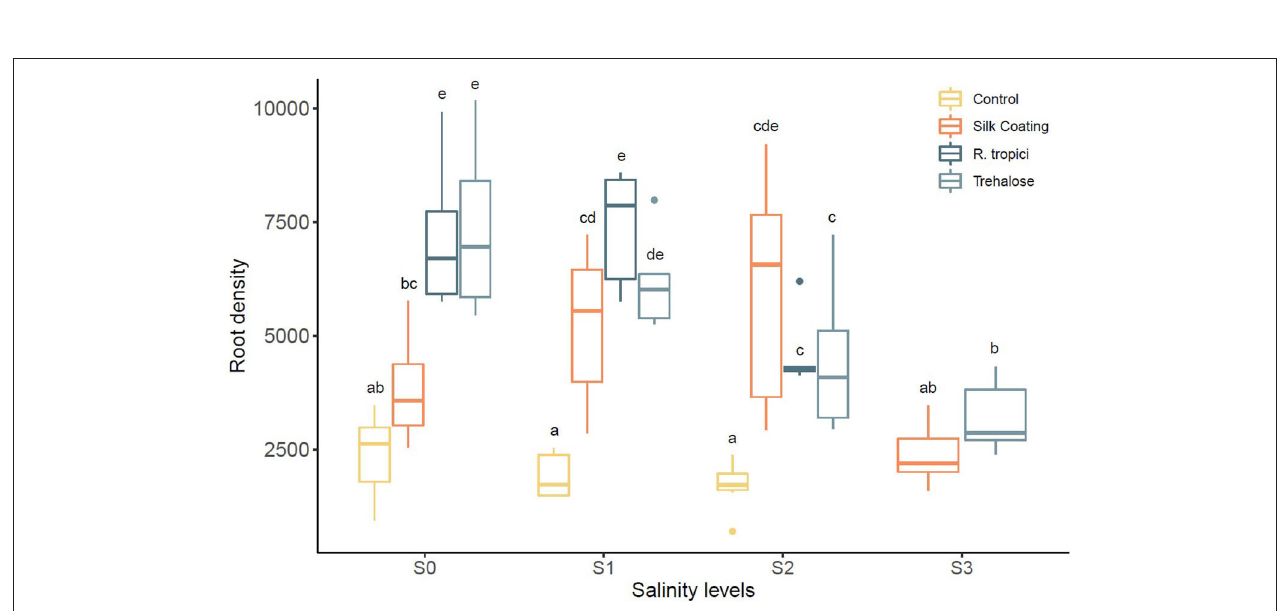
FIGURE 3 | Effect of different salinity levels ( S0 = 0mM, S1 = 25mM, S2 = 50mM, and S3 = 75mM) on Phaseolus vulgaris shoot length in centimeters.